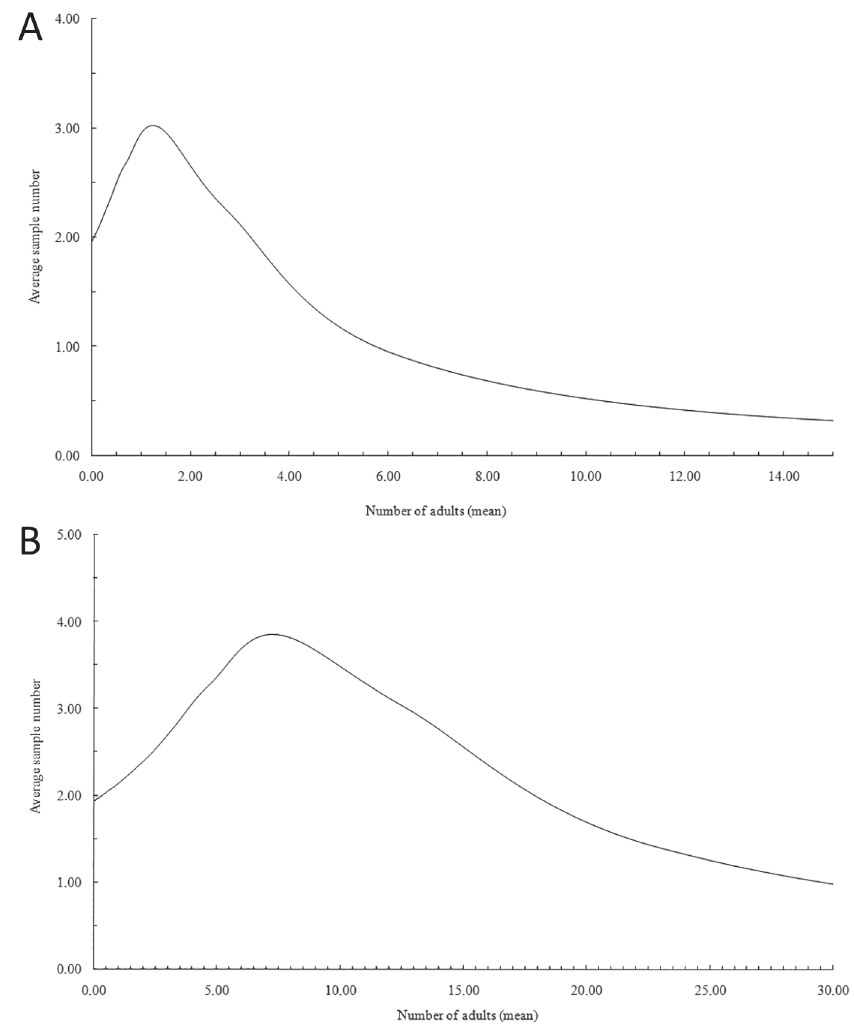
Figure 3 - Curve of the expected size of sample units (Average sample number) for the test sequential probability ratio to total population of adult Bemisia tuberculata (Hemiptera: Aleyrodidae) to the biological (A) and chemical (B)